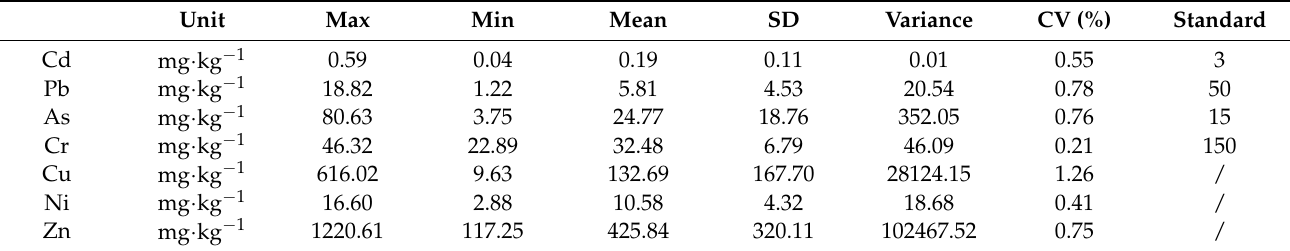
Table 3. Content of HMs in organic fertilizer.